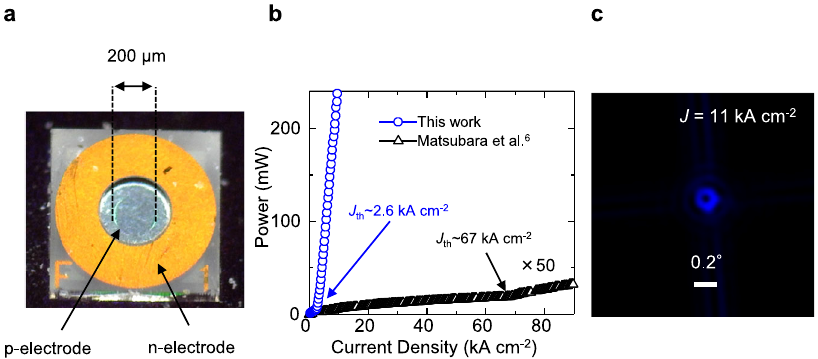
Fig. 3 Lasing characteristics of a GaN-based PCSEL with single-lattice photonic crystals operated under pulsed conditions at room temperature. a A microscope image of the fi nished device with a square-lattice photonic crystal with symmetric hexagonal air holes as shown in Fig. 2h and a circular current injection area with a diameter of 200 μ m. The backside p-electrode can be seen through the transparent GaN substrate. b Output power versus current density. c Measured far- fi eld pattern under an injection current density of 11 kA cm − 2